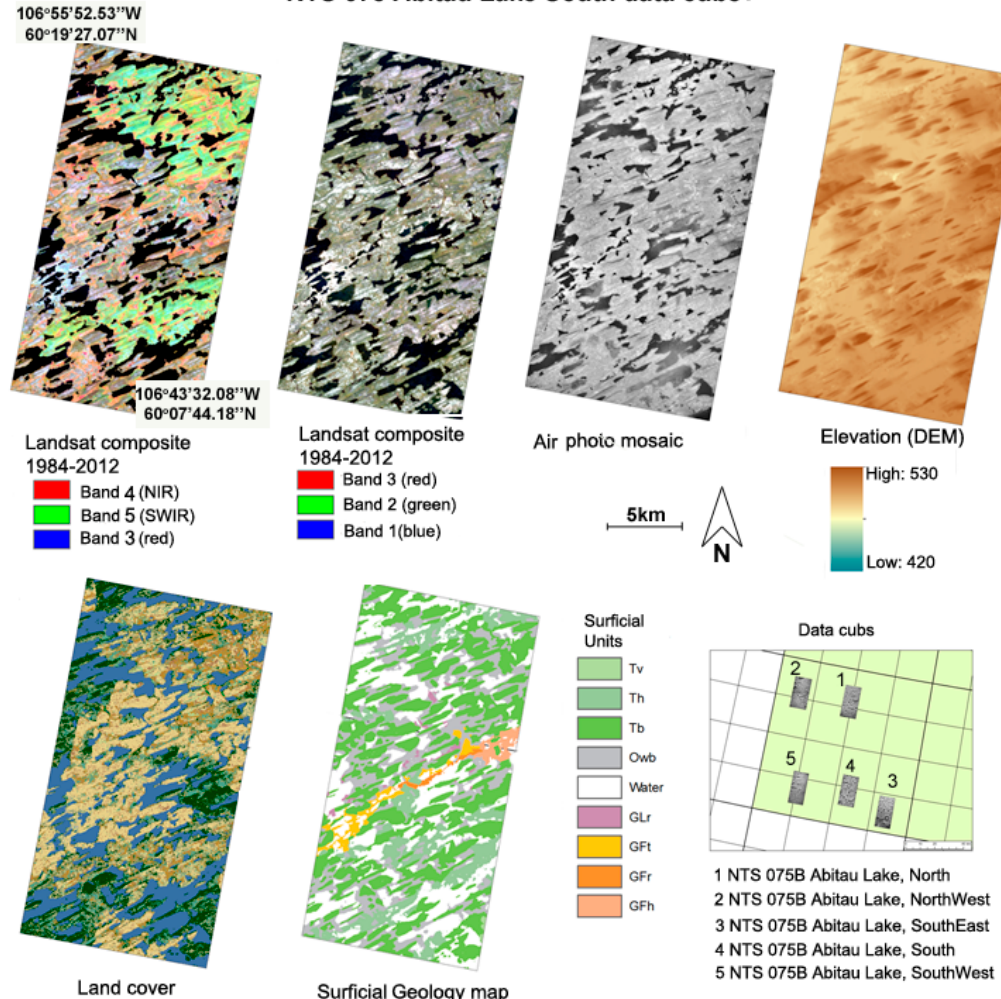
Figure 6. Example of the data cubes for National Topographic System map 075B Abitau study: these data sets are for the South subarea.